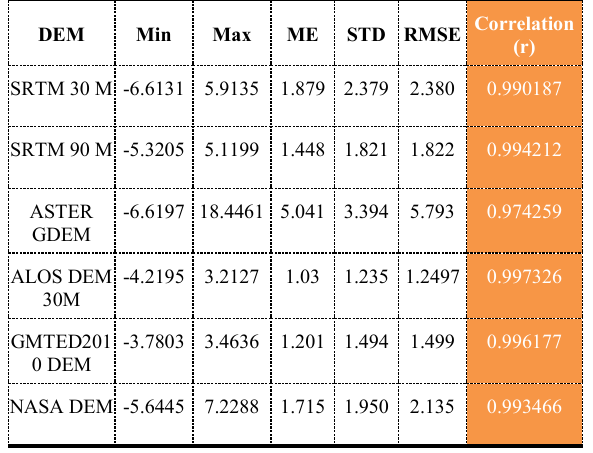
Figure 10. Histogram analysis of elevation difference between global DEMs from (a) SRTM 30m, (b) Aster-GDEM, (c) GMTED2010, (d) NASA DEM, (e) ALOS World 3D-30M, and (f) SRTM 90M datasets and GPS data. Table 1. Summary of statistical analysis of the validation of elevation values for the selected global